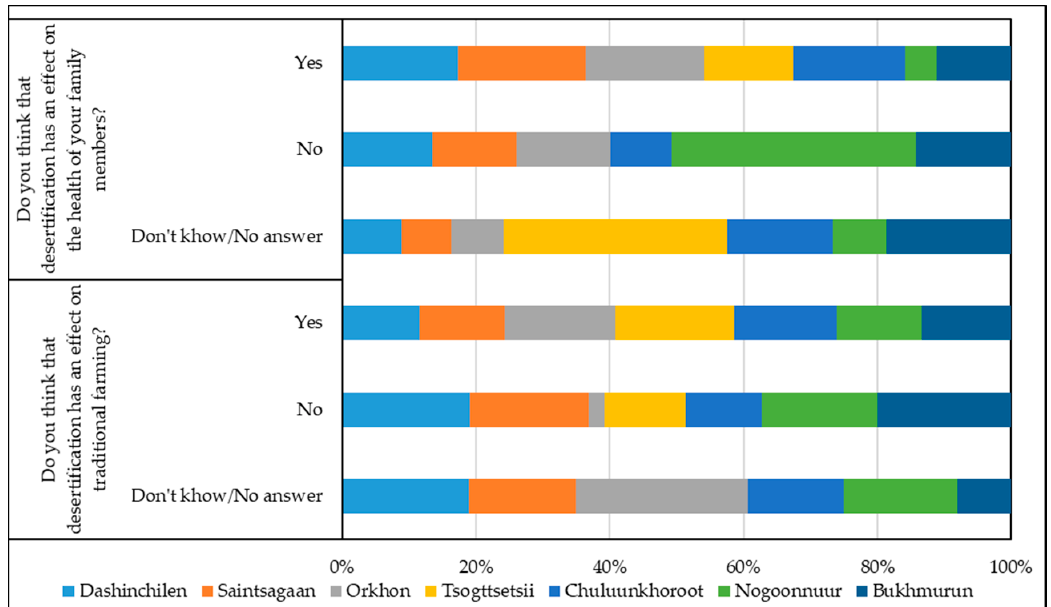
Figure 3. Distribution of answers to questions about the impact of desertification on traditional farming and public health.